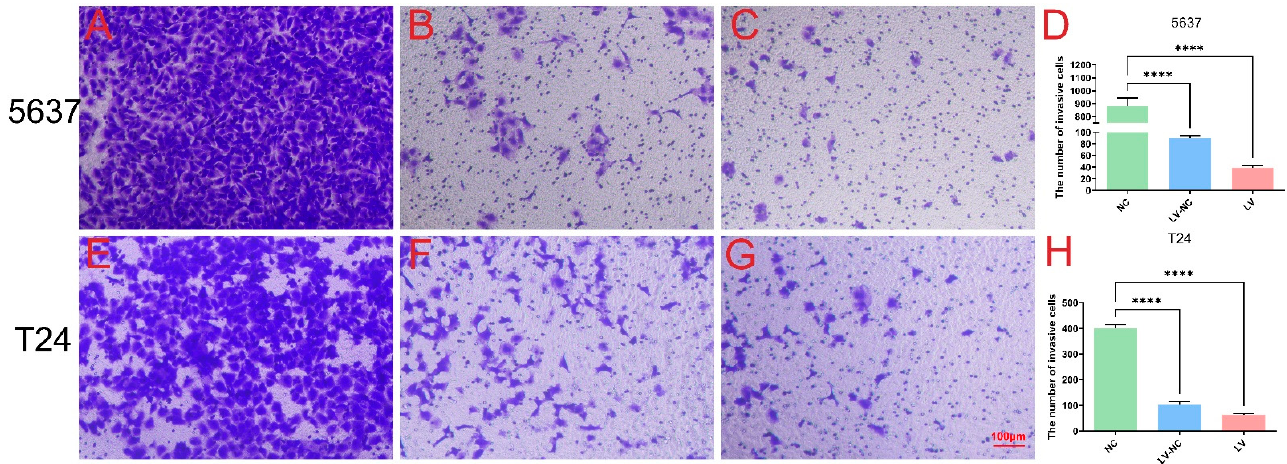
Figure 3. The Transwell invasion assay of three groups (transfection group, LV; negative control group, LV-NC; blank group, NC) in 5637 cells ( A – D ) and T24 cells ( E – H ). **** indicates p -value < 0.0001.